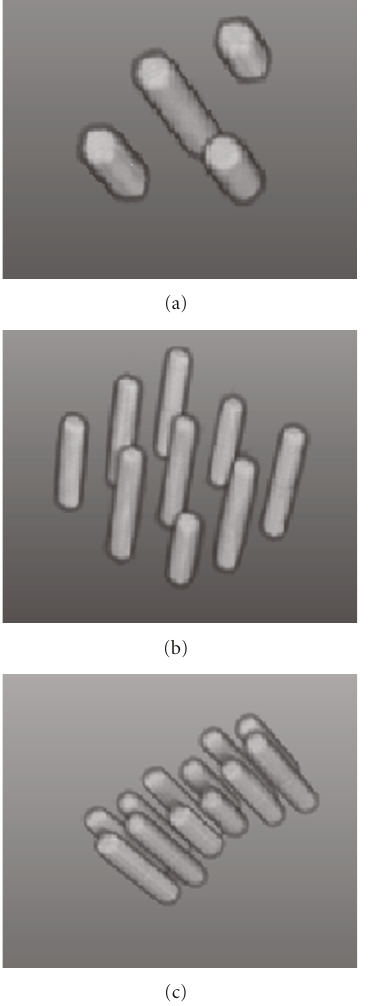
Figure 9: The three artificially generated datasets. (a) Very short fibers, wide spacing. (b) Medium length fibers, tighter spacing. (c) Varying length fibers, very tight spacing.